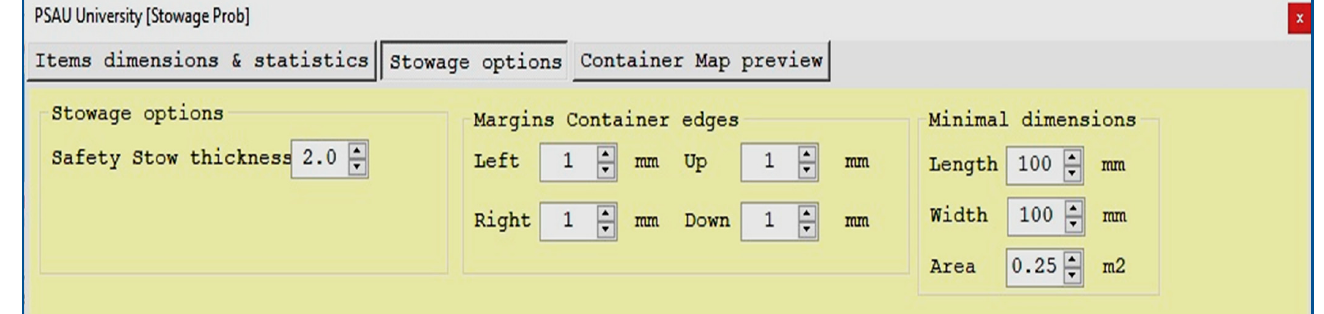
Figure A2. The efficiency of transportation system on distribution path aggregated via IoT for seven stations (n = 7).